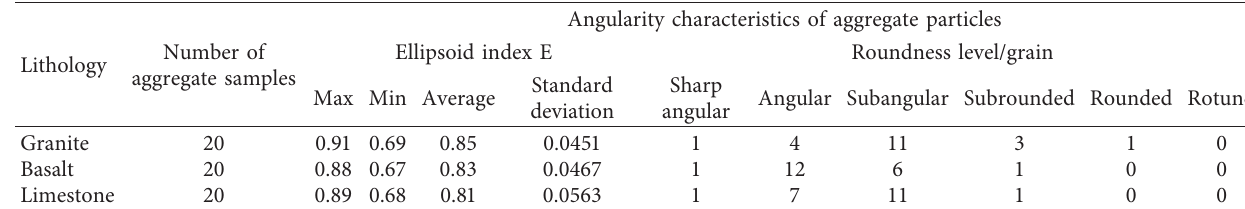
Table 7: The edge and angle feature of the aggregate samples.